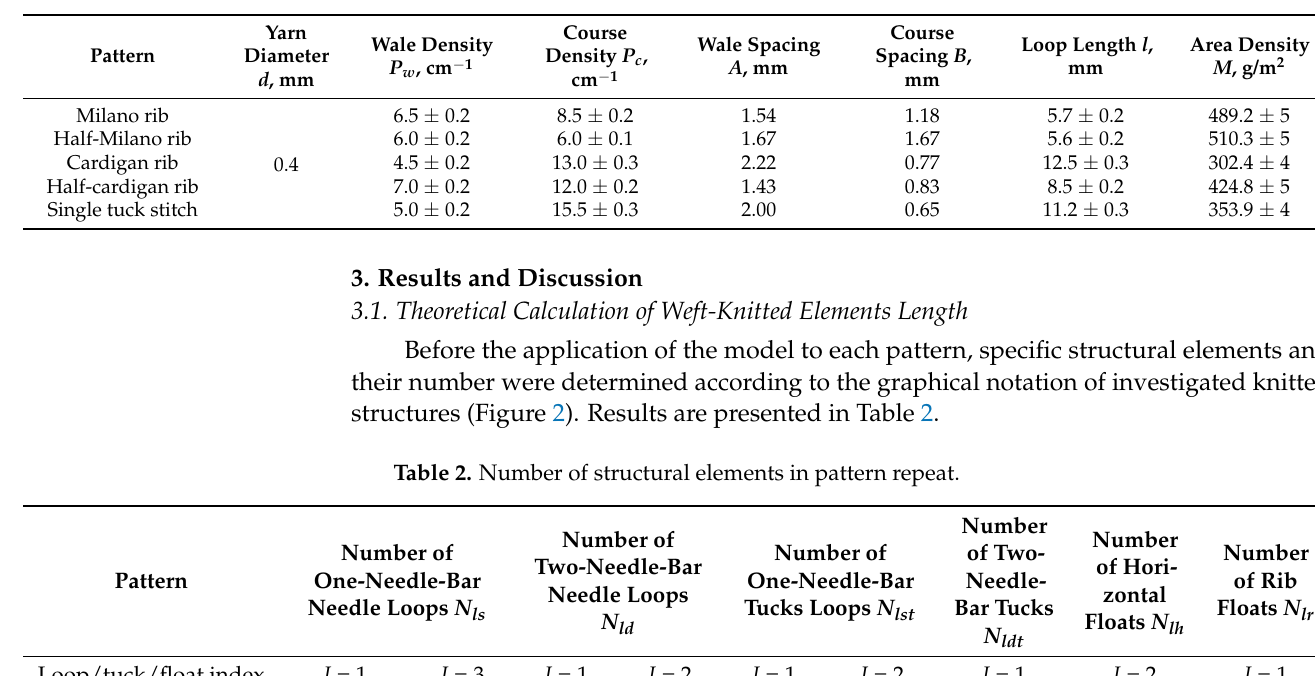
Table 1. Structural parameters of the investigated knits.